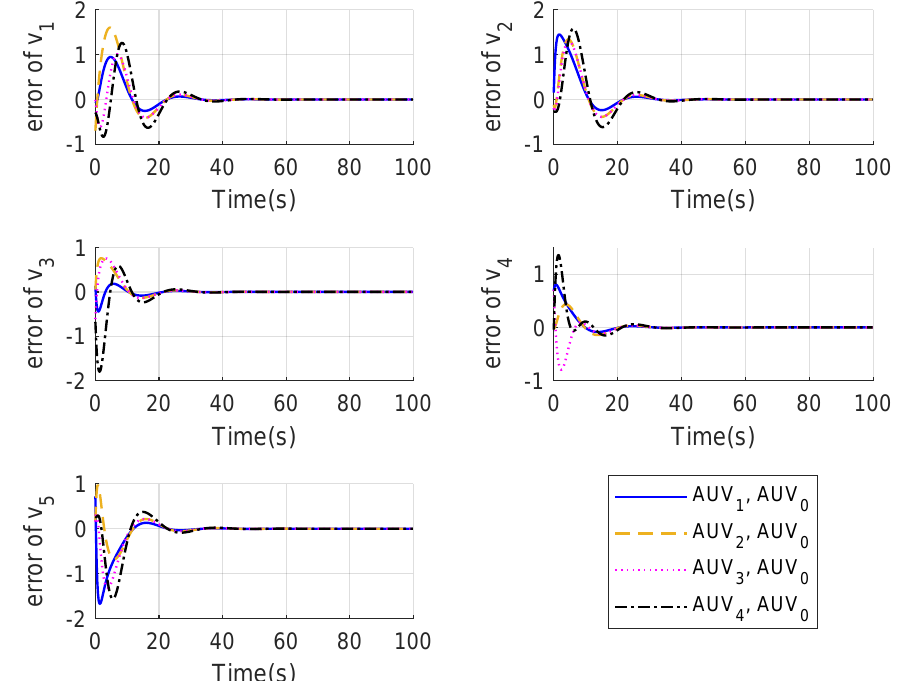
Figure 10. Errors of velocity state under alterable communication topology without